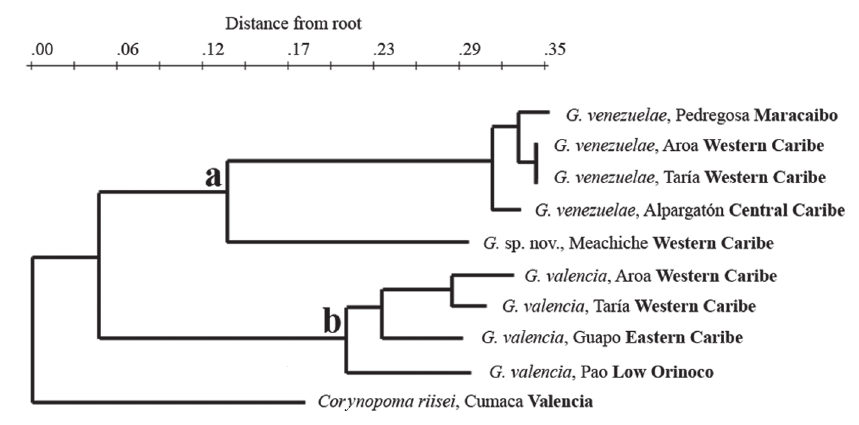
Fig. 2. Phylogenetic approach for the three species of Gephyrocharax in Venezuela. Corynopoma riisei is included as the external group (Names in bold denote major river basins referred to in the